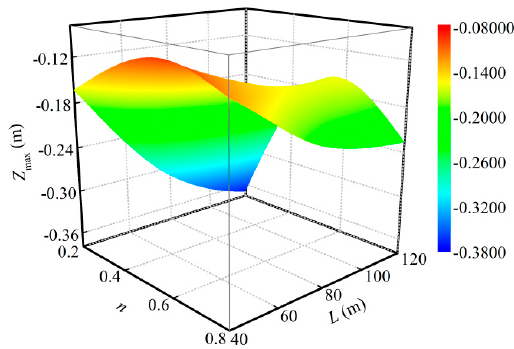
Figure 14. Coupling effect of the cemented rockfill’s granule gradation and mining distance on the maximum subsidence displacement of the coal seam roof. Table 8. Relationship between the maximum subsidence displacement of the coal seam roof and the Talbot index of the cemented rockfill at different mining distances. Mining Distance